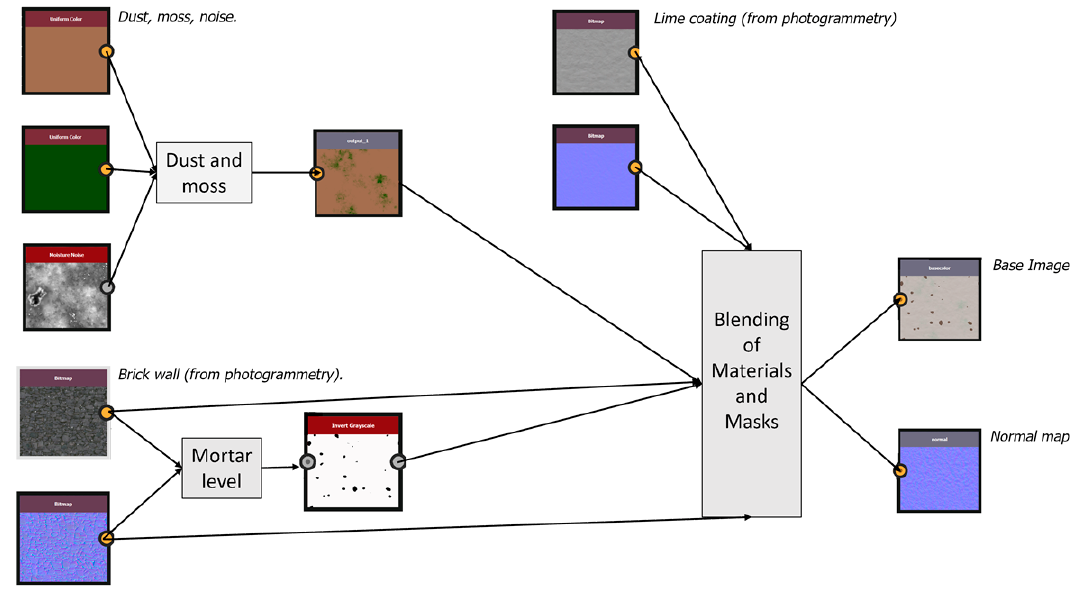
Figure 22. Procedural texture generation. A simplified view of the node graph corresponding to the generation of facade textures.